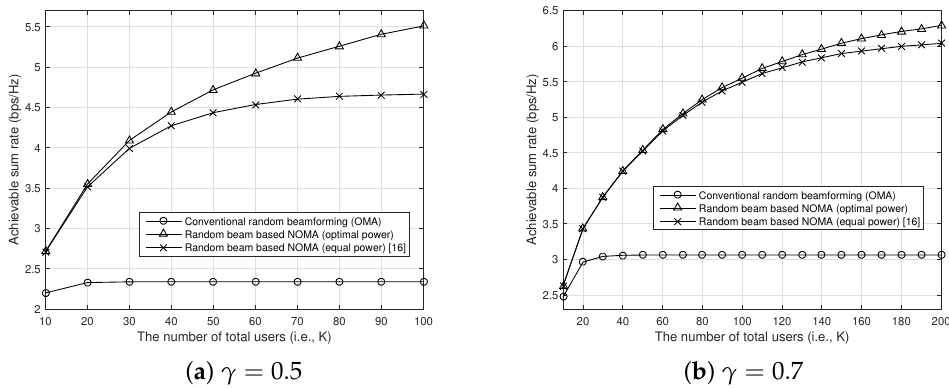
Figure 6. The achievable sum rate of our proposed random beam-based NOMA with respect to the number of users for various target SINRs (i.e., γ ) when the transmitter has four antennas, and SNR is 10